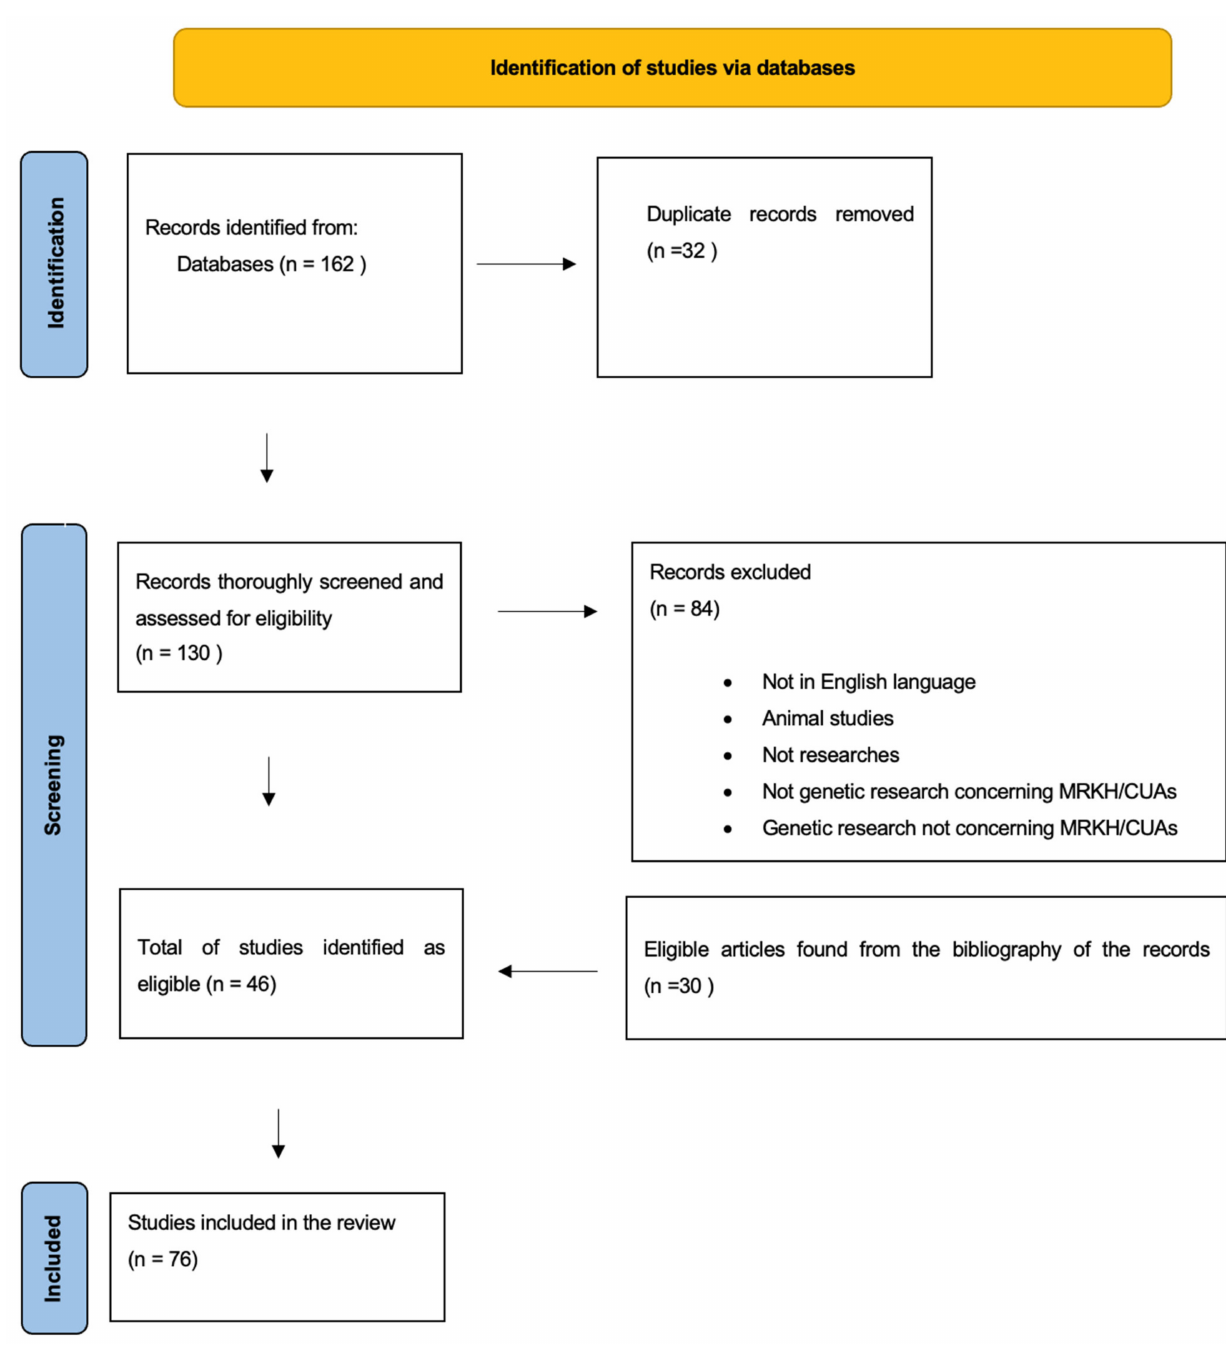
Figure 1. Identification process of the studies included in the Systematic